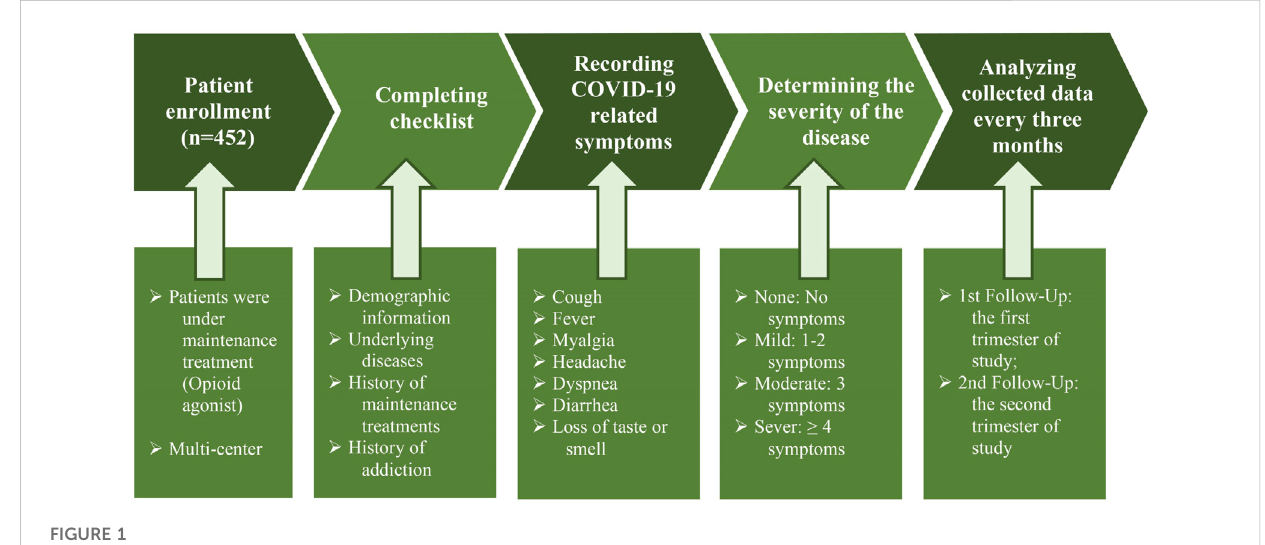
FIGURE 1 Flow diagram of participants through the